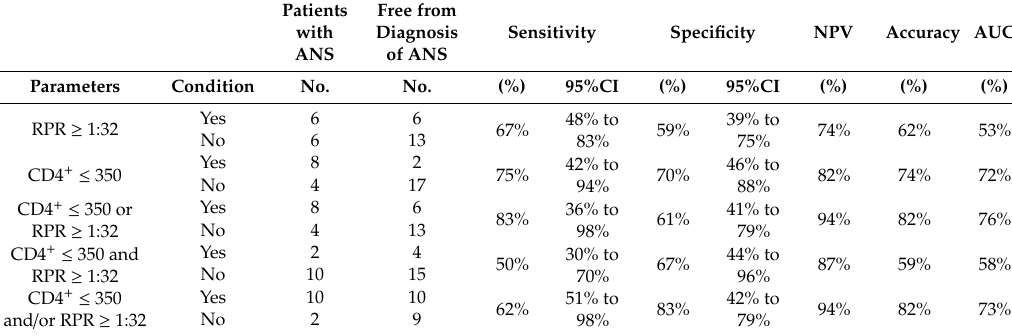
Figure 2. Receiver operating characteristic (ROC) curve of the CD4 + and / or Rapid Plasma Reagin (RPR) to detect the disease, calculated assuming di ff erent cut-o ff s. (CD4 + expressed in cells / mm 3 ). Table 2. Comparison of the area under the ROC curve (AUC) and optimal sensitivities and specificities of each parameter are shown in the associated table. Columns show: Parameters, negative cases, positive cases, sensitivity, specificity, negative predictive value (NPV), diagnostic accuracy, and AUC. (CD4 + expressed in cells / mm 3 ).